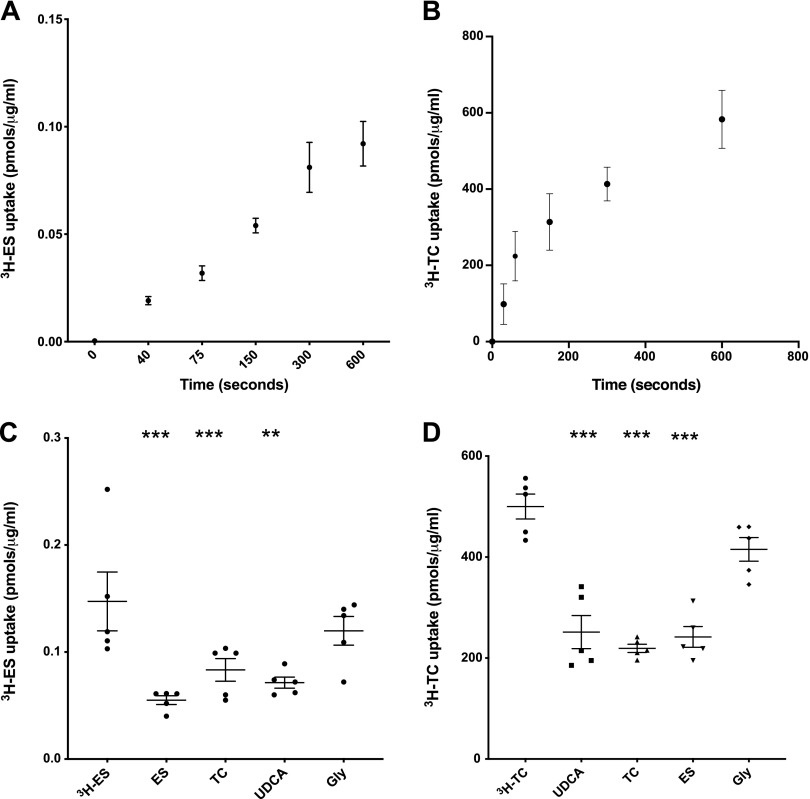
The uptake of OATP substrates, ES and TC, are inhibited by UDCA in placental villous fragments. A) 3H-ES uptake by villous fragments was shown to be linear up to 5 min (n = 2 placentas). B) 3H-TC uptake by villous fragments was shown to be linear up to 2.5 min (n = 3 placentas). C) 3H-ES uptake was inhibited by 1 mM ES (***P < 0.001, n = 5), 1 mM TC (***P < 0.001, n = 5), and 1 mM UDCA (**P < 0.01, n = 5) but not by the negative control glycine (n = 5). D) 3H-TC uptake was inhibited by 100 μM UDCA (***P < 0.01, n = 5), 100 μM TC (**P < 0.01, n = 5), and 100 μM ES (***P < 0.01, n = 5), but not by the negative control glycine (n = 5). Data are presented as means and sem and were analyzed by a 1-way ANOVA with Dunnett’s post hoc (compared with 3H-ES and 3H-TC alone).